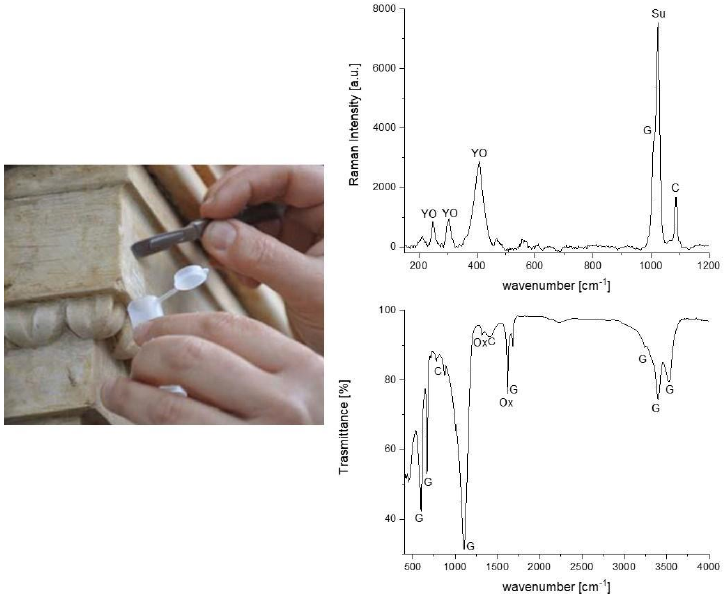
Figure 7. Raman and FT-IR spectra of the yellow-brownish patina: YO, yellow ochre; G, gypsum; Su, calcium sulphate; C, calcite; Ox, calcium oxalate.